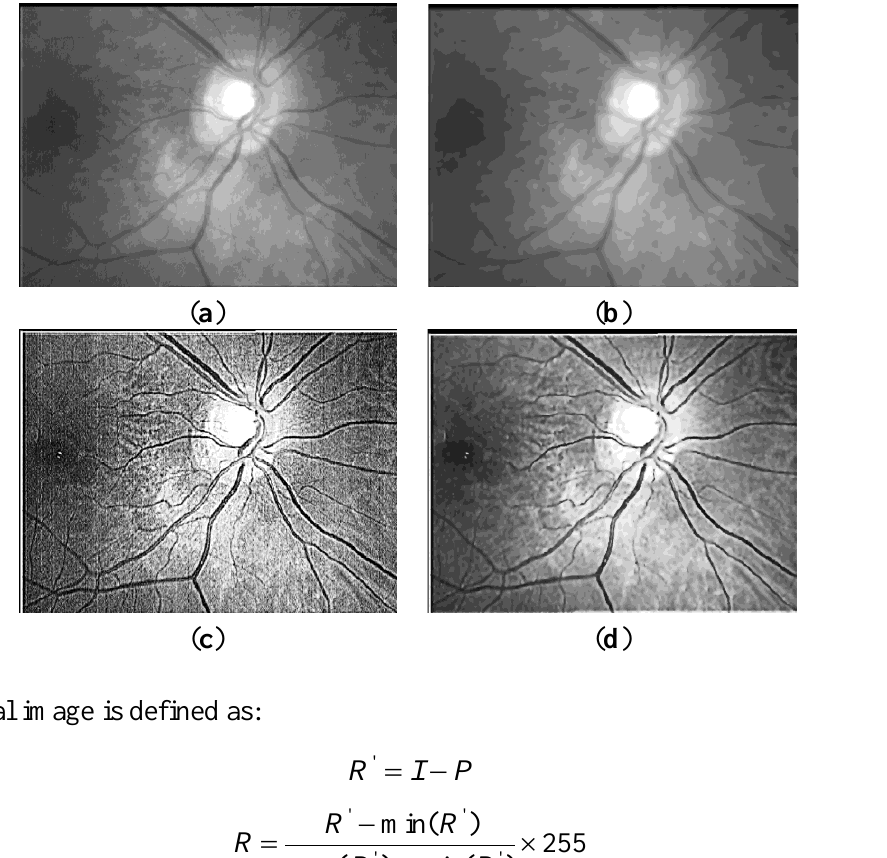
Figure 5. ( a ) The original retina image; ( b ) the bias like image which is (a) processed by the ICGF; ( c ) (a) subtract (b); ( d ) Result image of preprocessing which is (c) after nonlinear anisotropic